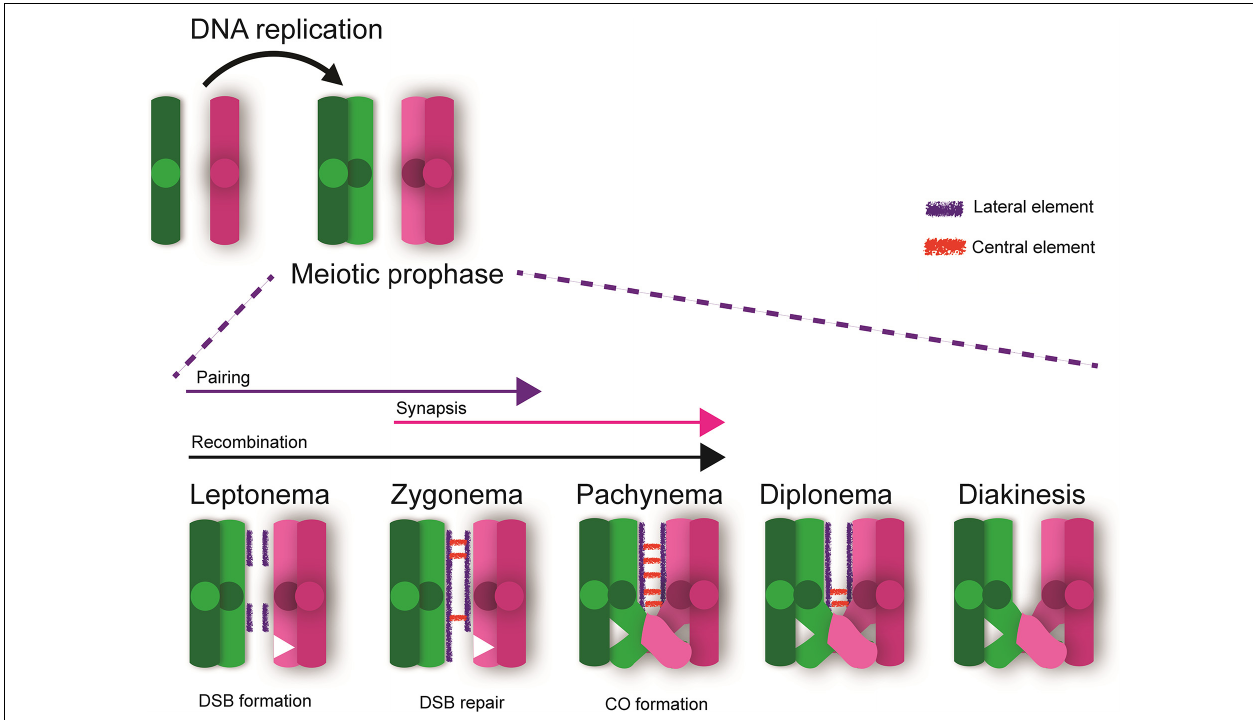
FIGURE 1 | Meiotic Prophase I. Following DNA replication, meiotic prophase initiates. DNA double strand breaks (DSBs) are created during leptonema and the chromosomes initiate the processes of pairing and recombination. These processes progress into zygonema with DSB repair mechanisms ensuring proper homologous recombination. By pachynema, the chromosomes are fully synapsed and sites of crossovers (CO) are apparent. Sites of CO tether the homologous chromosomes together until anaphase I, allowing for proper segregation of homologous chromosomes and reducing the risk of aneuploidy in future gametes. Diplonema is marked by breakdown of the central element of the synaptonemal complex and chromosomes begin to repel each other. By diakinesis, homologous chromosomes are only tethered at the sites of crossovers and sister chromatids at the centromeres.